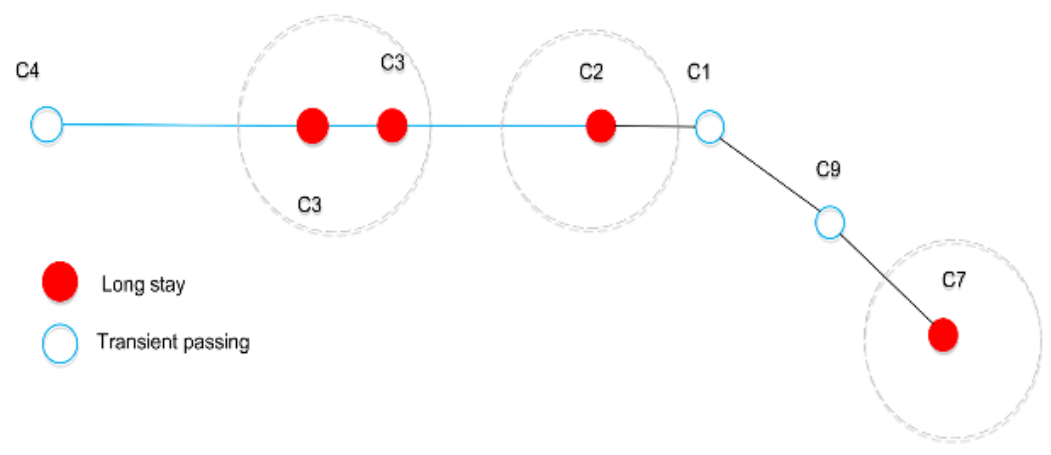
Figure 4. The sequence of a moving object trajectory.